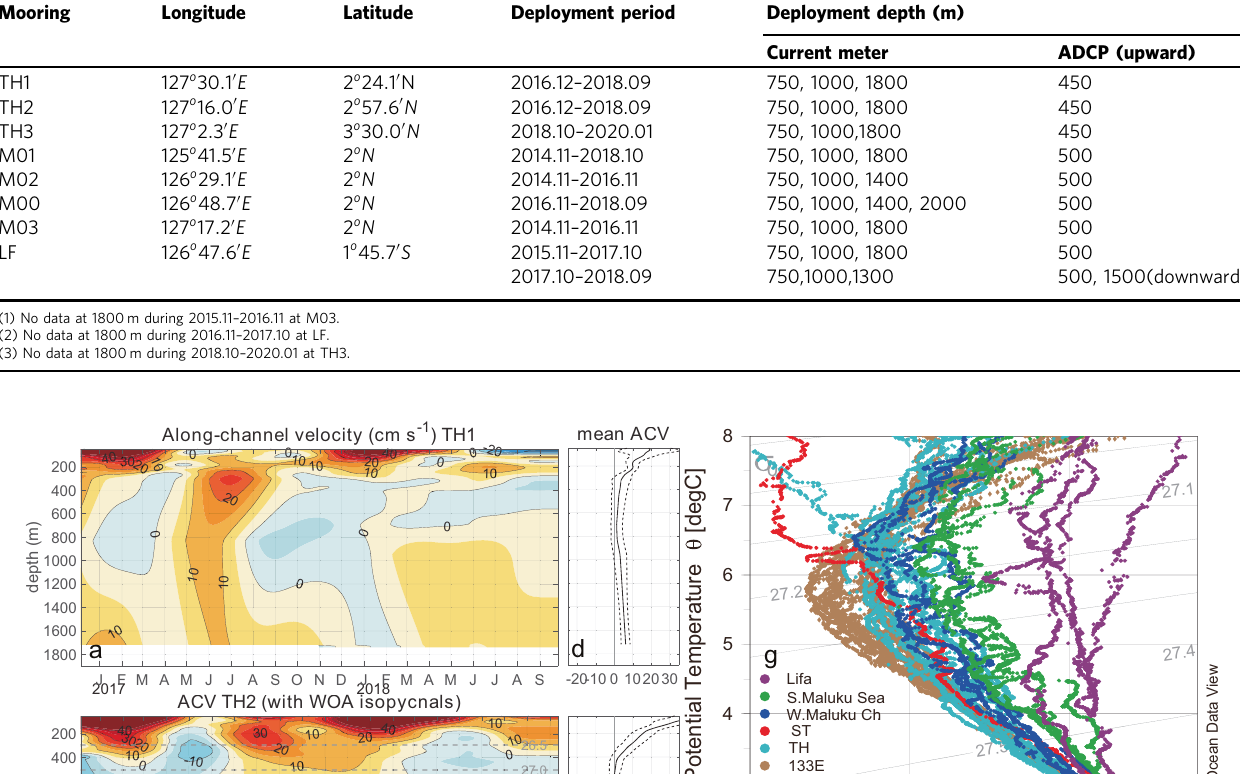
Table 1 Con fi gurations of the moorings in the Maluku Channel, Lifamatola Passage, and the Talaud-Halmahera Channel. Mooring Longitude Latitude Deployment period Deployment depth (m)